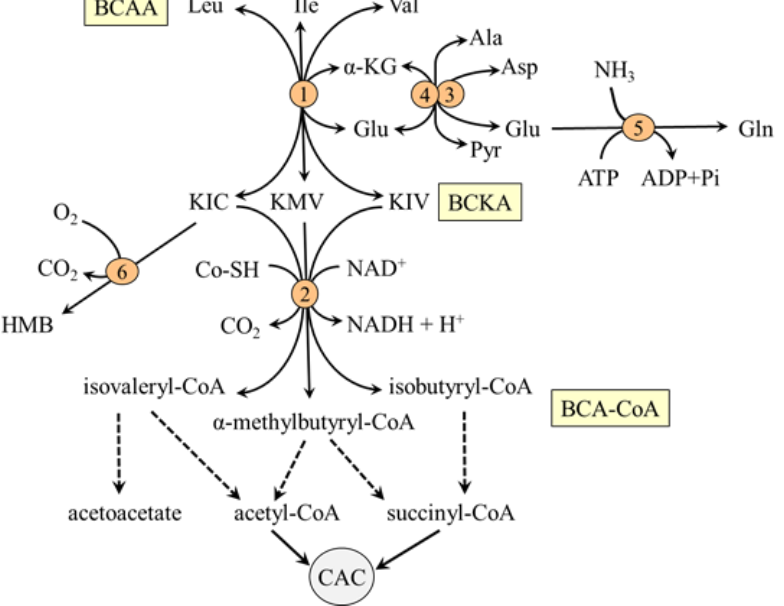
Figure 3 . Main pathways of BCAA catabolism. 1, BCAA aminotransferase; 2, BCKA dehydrogenase; 3, AST; 4, ALT; 5, glutamine synthetase; 6, KIC dioxygenase. BCAA, branched-chain amino acids; BCA-CoA, branched-chain acyl-CoA; BCKA, branched-chain keto acids; CAC, citric acid cycle; HMB, β -hydroxy- β -methylbutyric acid; OA,